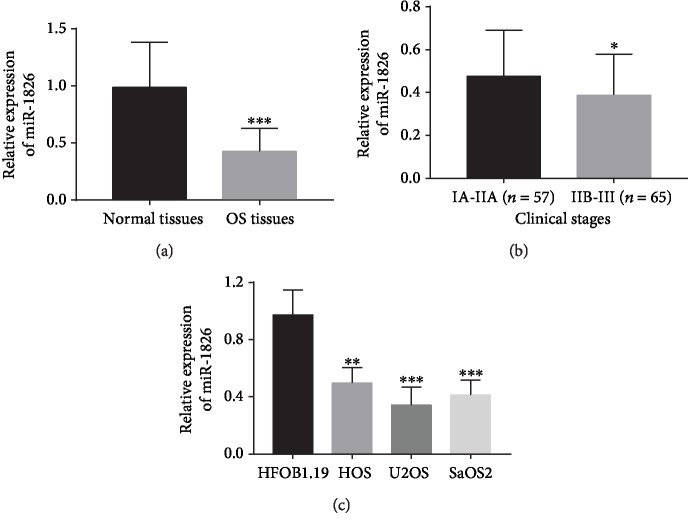
Expression of miR-1826 in OS tissues and cell lines. (a) miR-1826 expression was decreased in OS tissues compared with the normal controls. (b) miR-1826 expression was downregulated in OS patients with advanced clinical stage compared with those with early stage. (c) Downregulated expression of miR-1826 was found in the OS cell lines compared with the normal osteoblast cell line. ∗P < 0.05, ∗∗P < 0.01, ∗∗∗P < 0.001.